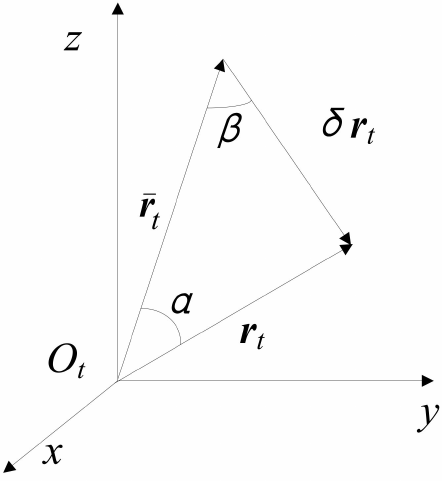
Figure 1. Geometric interpretation of a pseudorange